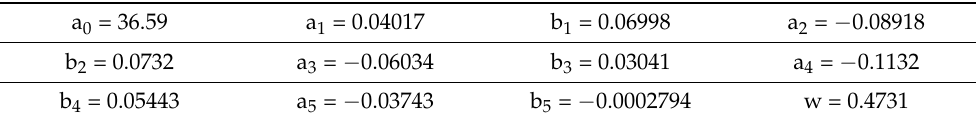
Table 4. The db series wavelet packet base corresponded to the parameter values of the SNR fitting function.